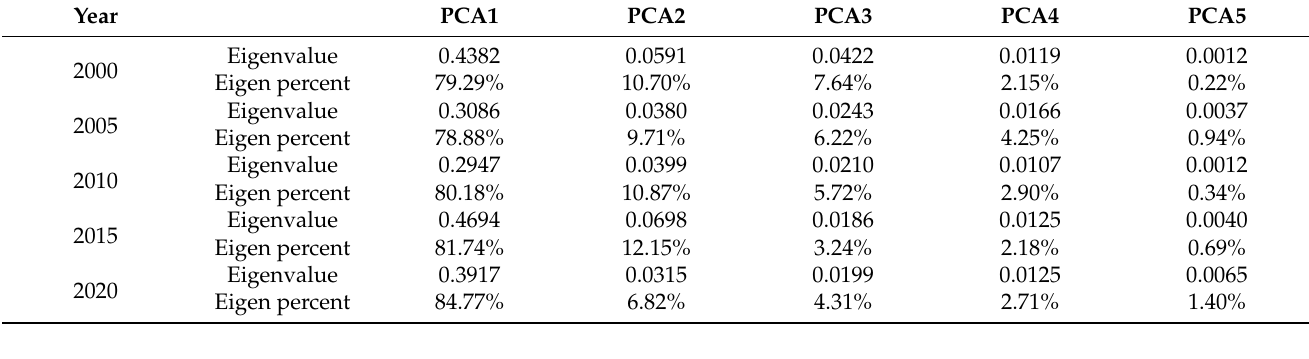
Table 4. Eigenvalue and eigen percentage of principal components analysis (PCA).